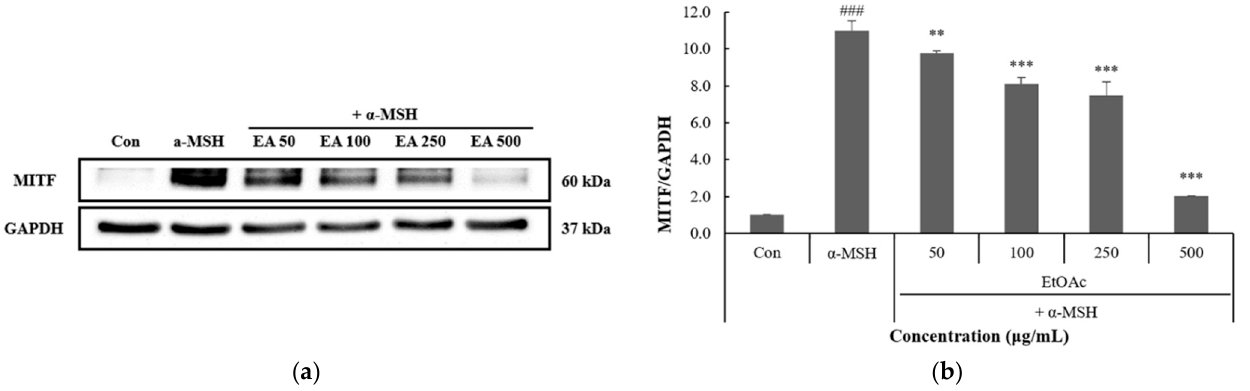
Figure 3. ( a ) Effect of the P. thunbergiana L. EtOAc fraction on MITF expression. ( b ) Band intensity compared to the control (GAPDH) was determined using TotalLab 1D software (TotalLab, Newcastle, UK). The results are expressed as the mean ± SD from three independent experiments. ### p < 0.001 compared with the control; ** p < 0.01 and *** p < 0.001 compared with α -MSH.